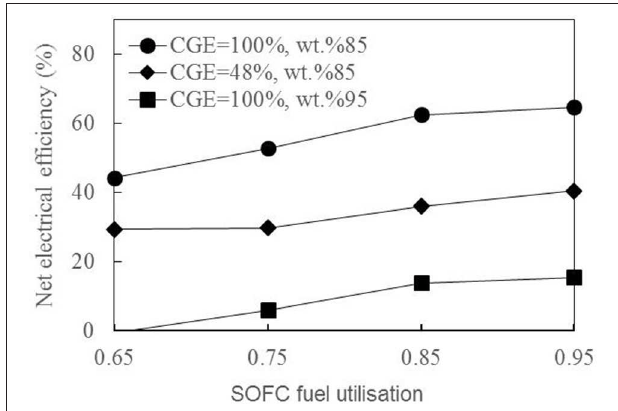
TABLE 5 | Key data and results from supercritical water gasification (SCWG) solid oxide fuel cell (SOFC). Process SCWG-SOFC Plasma-assisted